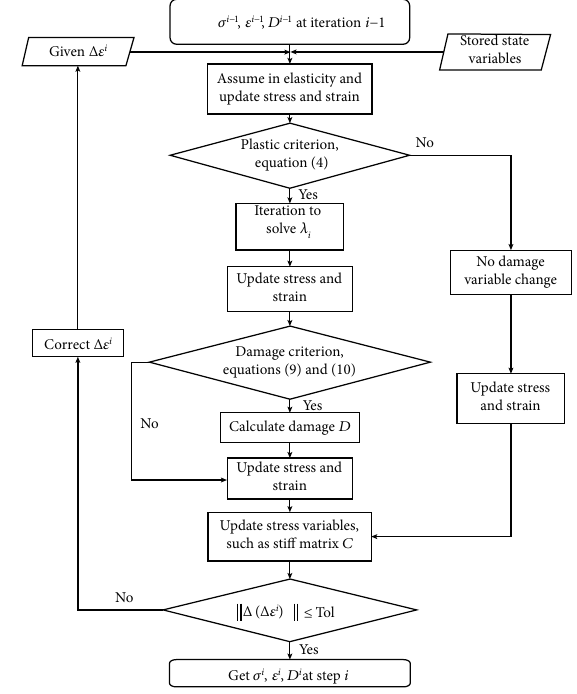
Figure 14: Flowchart for numerical simulation. Table 4: Material parameters of shale used in the simulations.